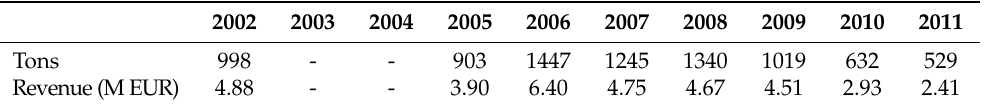
Table 2. Trend of the average quantities of clams caught in the Friuli-Venezia Giulia maritime compartment and related revenues in millions of euros (IREPA Onlus) [79–88].